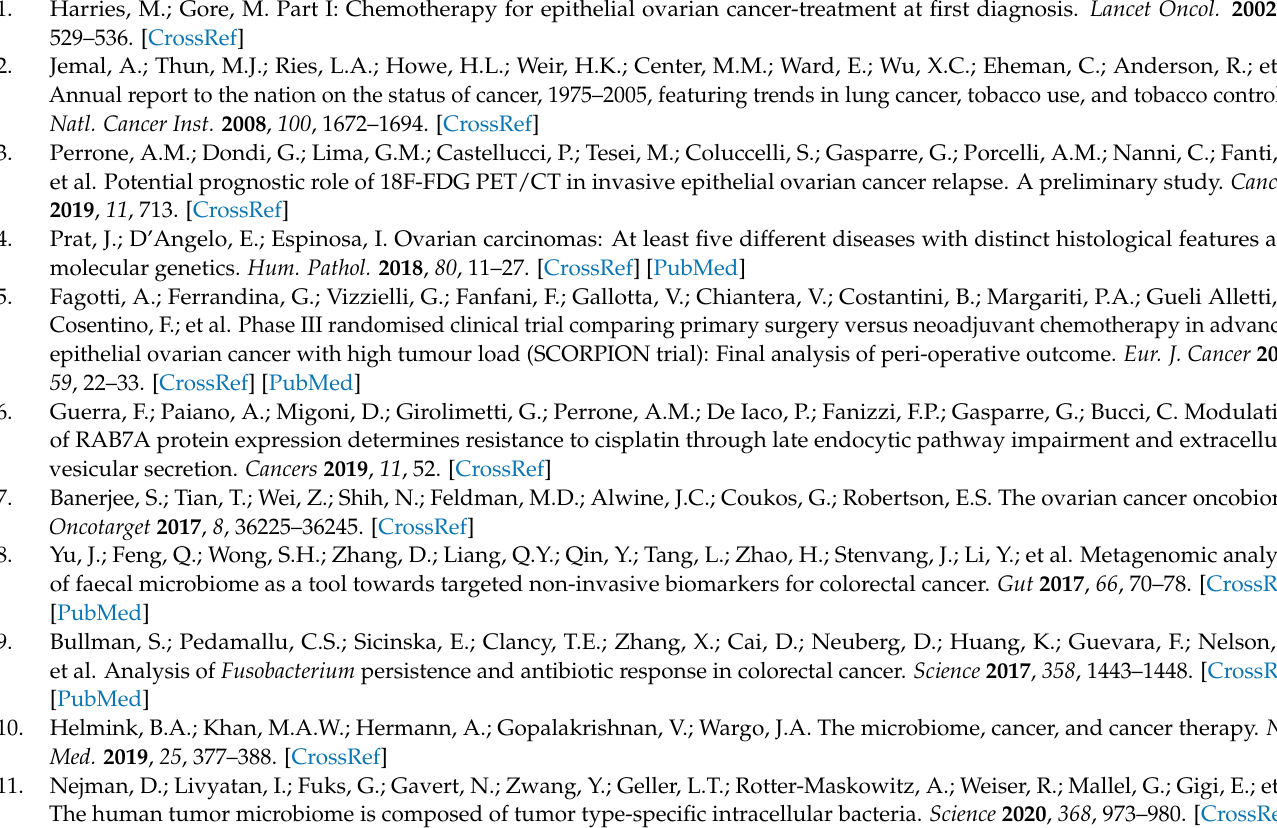
Figure S5: Temporal dynamics of the main discriminating taxa for platinum-resistant or platinum- sensitive EOC patients during neoadjuvant or adjuvant chemotherapy, Figure S6: Association of gut microbial taxa and survival in EOC patients receiving chemotherapy treatments, Figure S7: Variations in the potential gut microbial signatures of therapeutic response in the follow-up, up to 6 months after the end of therapy, Figure S8: Assignment of bacterial co-abundance groups (CAGs), Table S1: Meta- Cyc pathway and superclass information for the discriminating pathways between platinum-resistant and platinum-sensitive EOC patients receiving neoadjuvant or adjuvant